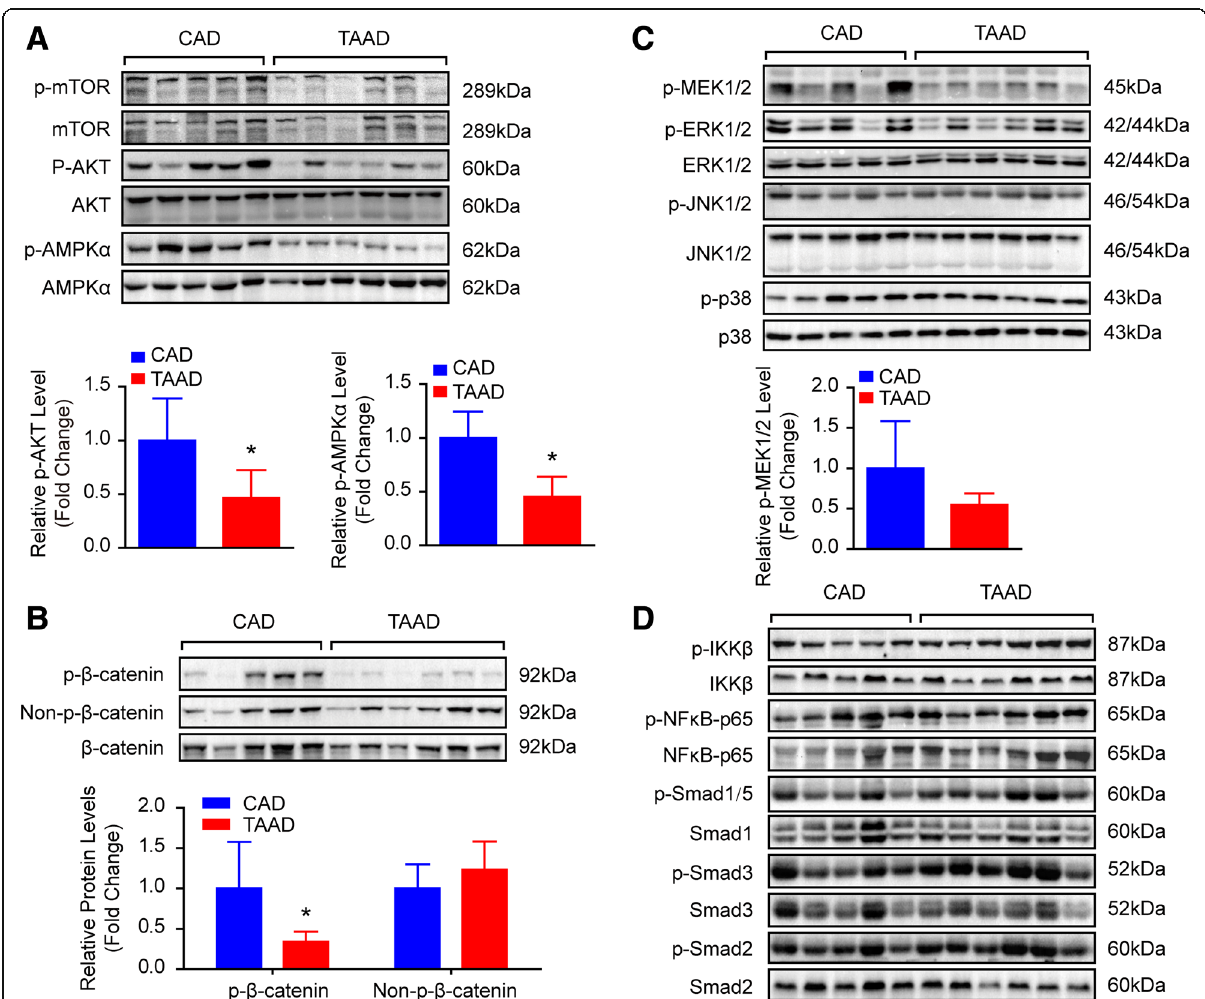
Fig. 5 The signaling pathways evaluated in human aorta samples. The phosphorylation and total protein levels of key molecules in signaling pathways were detected by western blot in the aorta of CAD and TAAD patients. a The phosphorylation and total protein levels of mTOR, AKT and AMPK α ; ( b ) The phosphorylation, non-phosphorylation and total protein levels of β -catenin; ( c ) The phosphorylation and total protein levels of MEK1/2, ERK1/2, JNK1/2, and P38; ( d ) The phosphorylation and total protein levels of IKK β , NF- κ B-p65, Smad1/5, Smad2, and Smad3. n = 6 pooled samples per group, * p < 0.05 vs.